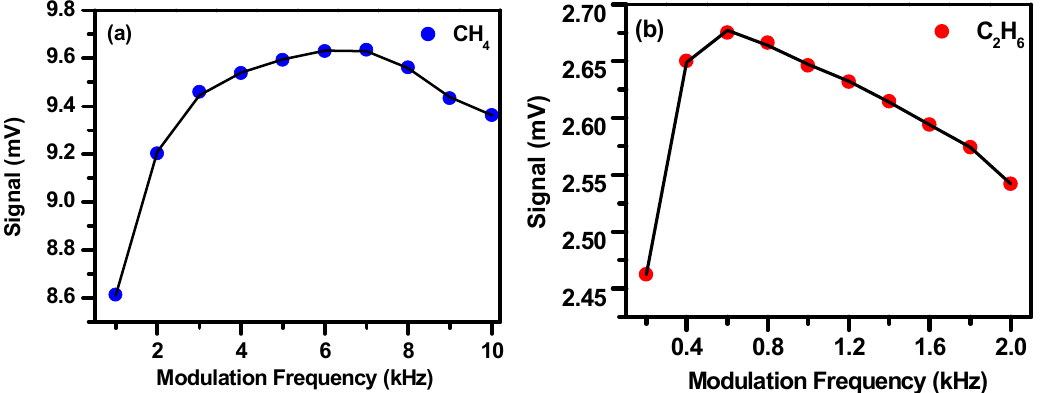
Figure 7. The 2f signal amplitudes vs. modulation frequencies for CH 4 ( a ) and C 2 H 6 ( b ).